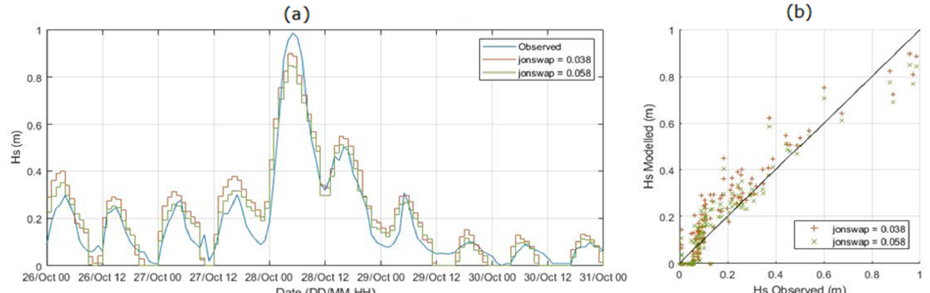
Figure C2. Comparison of observed and modeled significant wave heights with the advised and calibrated bed friction at measurement station ‘Wierummerwad’ ( a ) over time and ( b ) in a scatter plot with an identity line (black solid line).